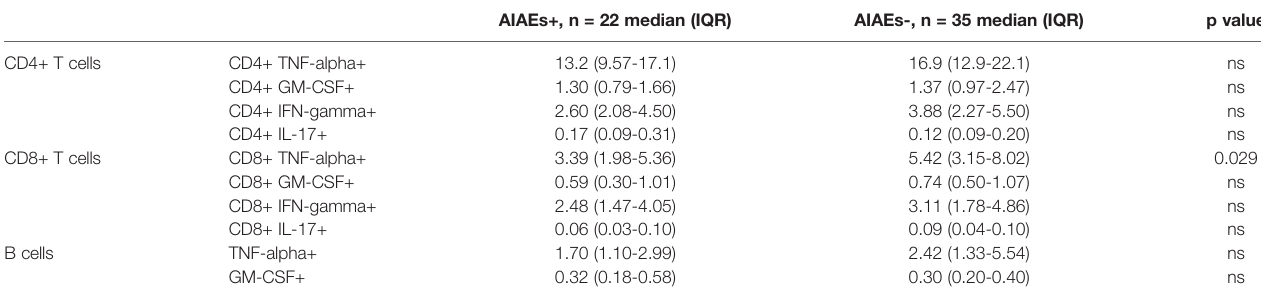
TABLE 4 | Percentages of T and B cells producing pro-in fl ammatory cytokines at baseline.